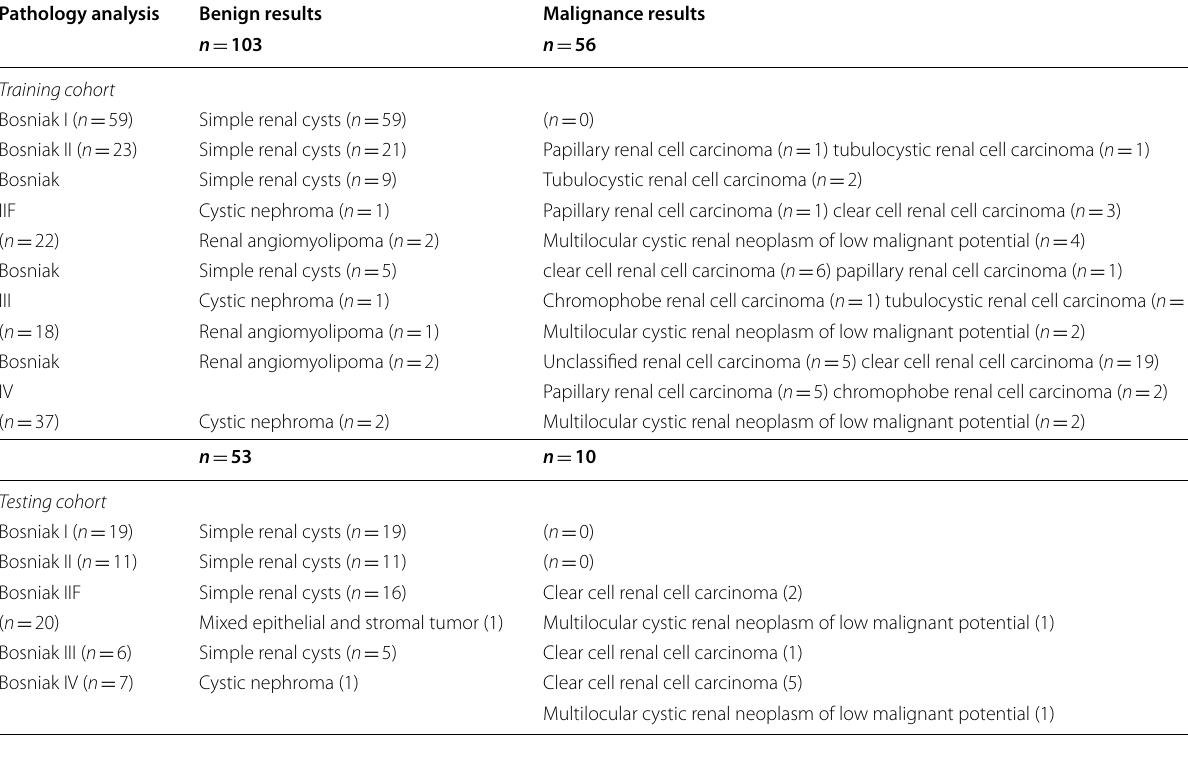
Table 1 Detailed distribution of Bosniak‑2019 classification and pathology results in the training cohort and external validation cohort Pathology analysis